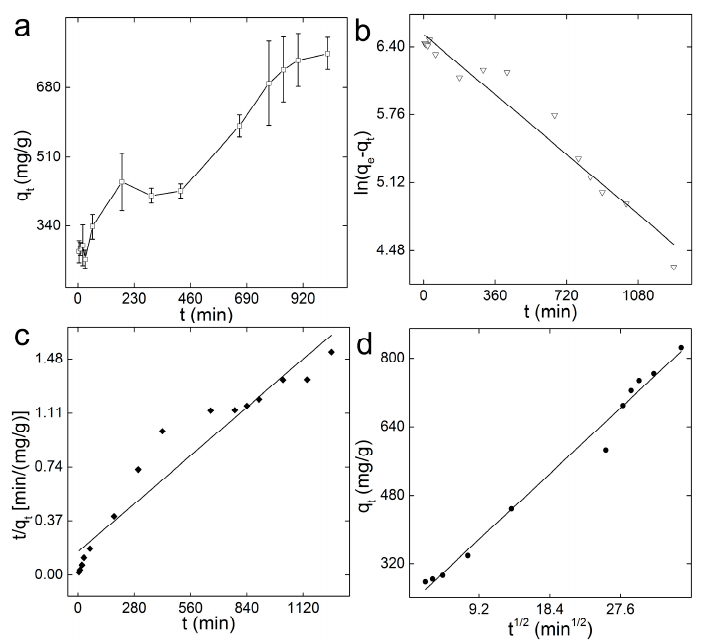
Figure 4. Kinetics analysis of the adsorption of MB onto GO-COOH. ( a ) Adsorption as a function of time. Data represent mean ± SD ( n = 3); ( b ) the pseudo-first-order model; ( c ) the pseudo-second-order model; ( d ) the intra-particle model.